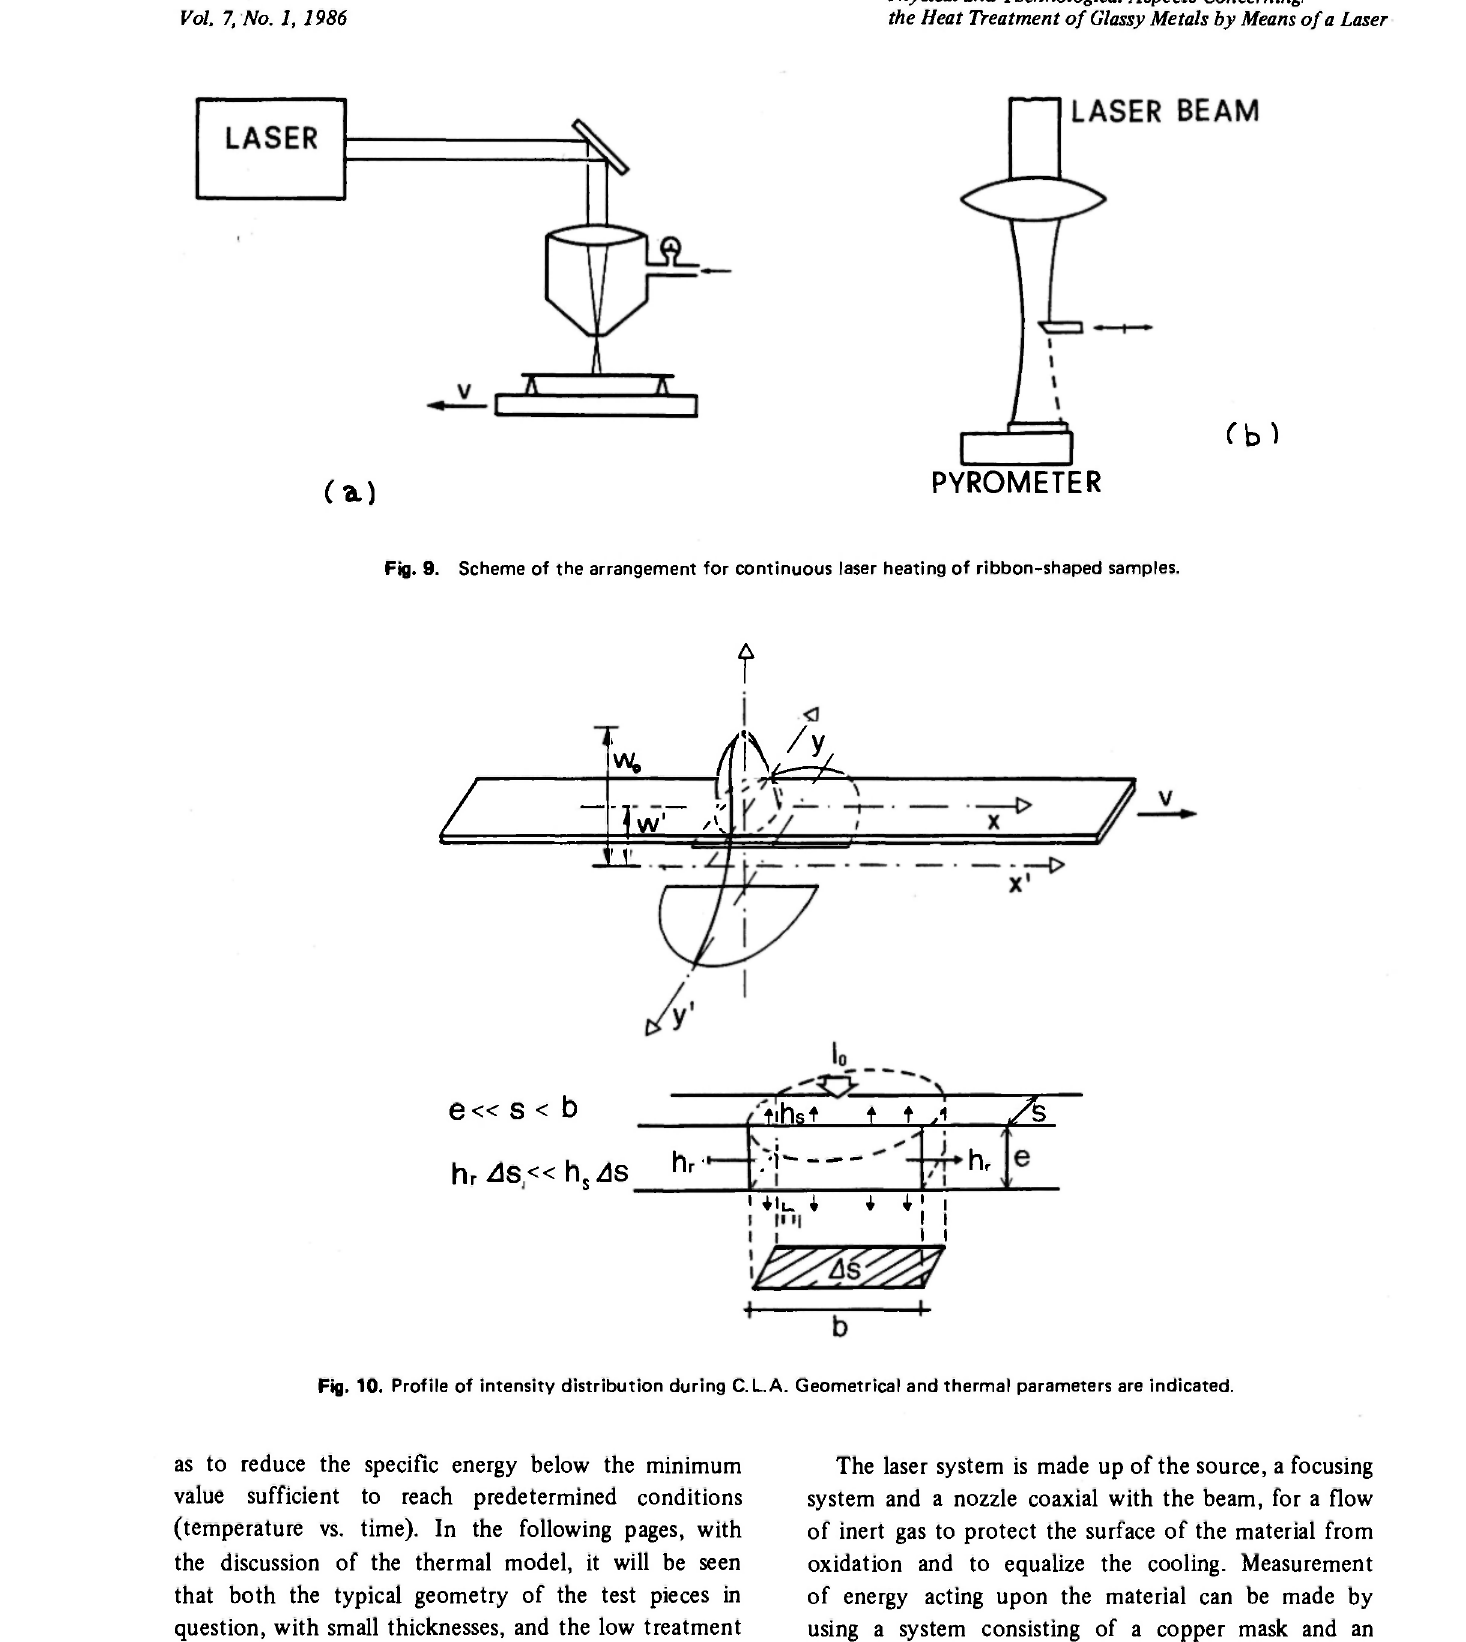
Fig. 10. Profile of intensity distribution during C. L.A. Geometrical and thermal parameters are